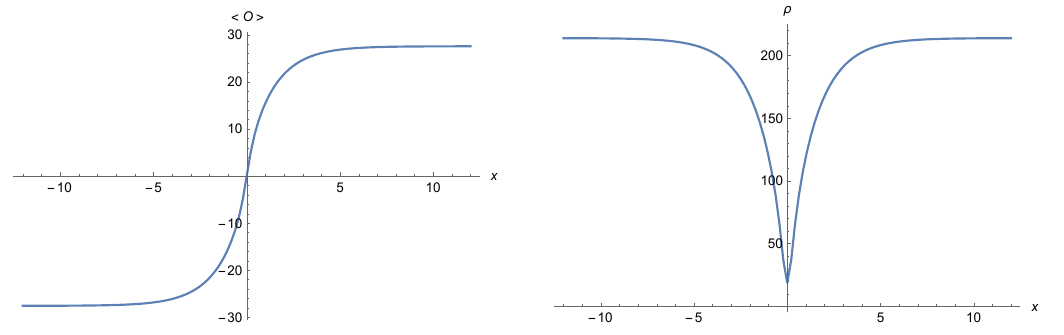
Figure 3 . The bulk con(cid:12)gurations of the (cid:12)elds (cid:30) ( z; x ) (left panel) and A t ( z; x ) (right panel) for (cid:22) = 5 : 5.